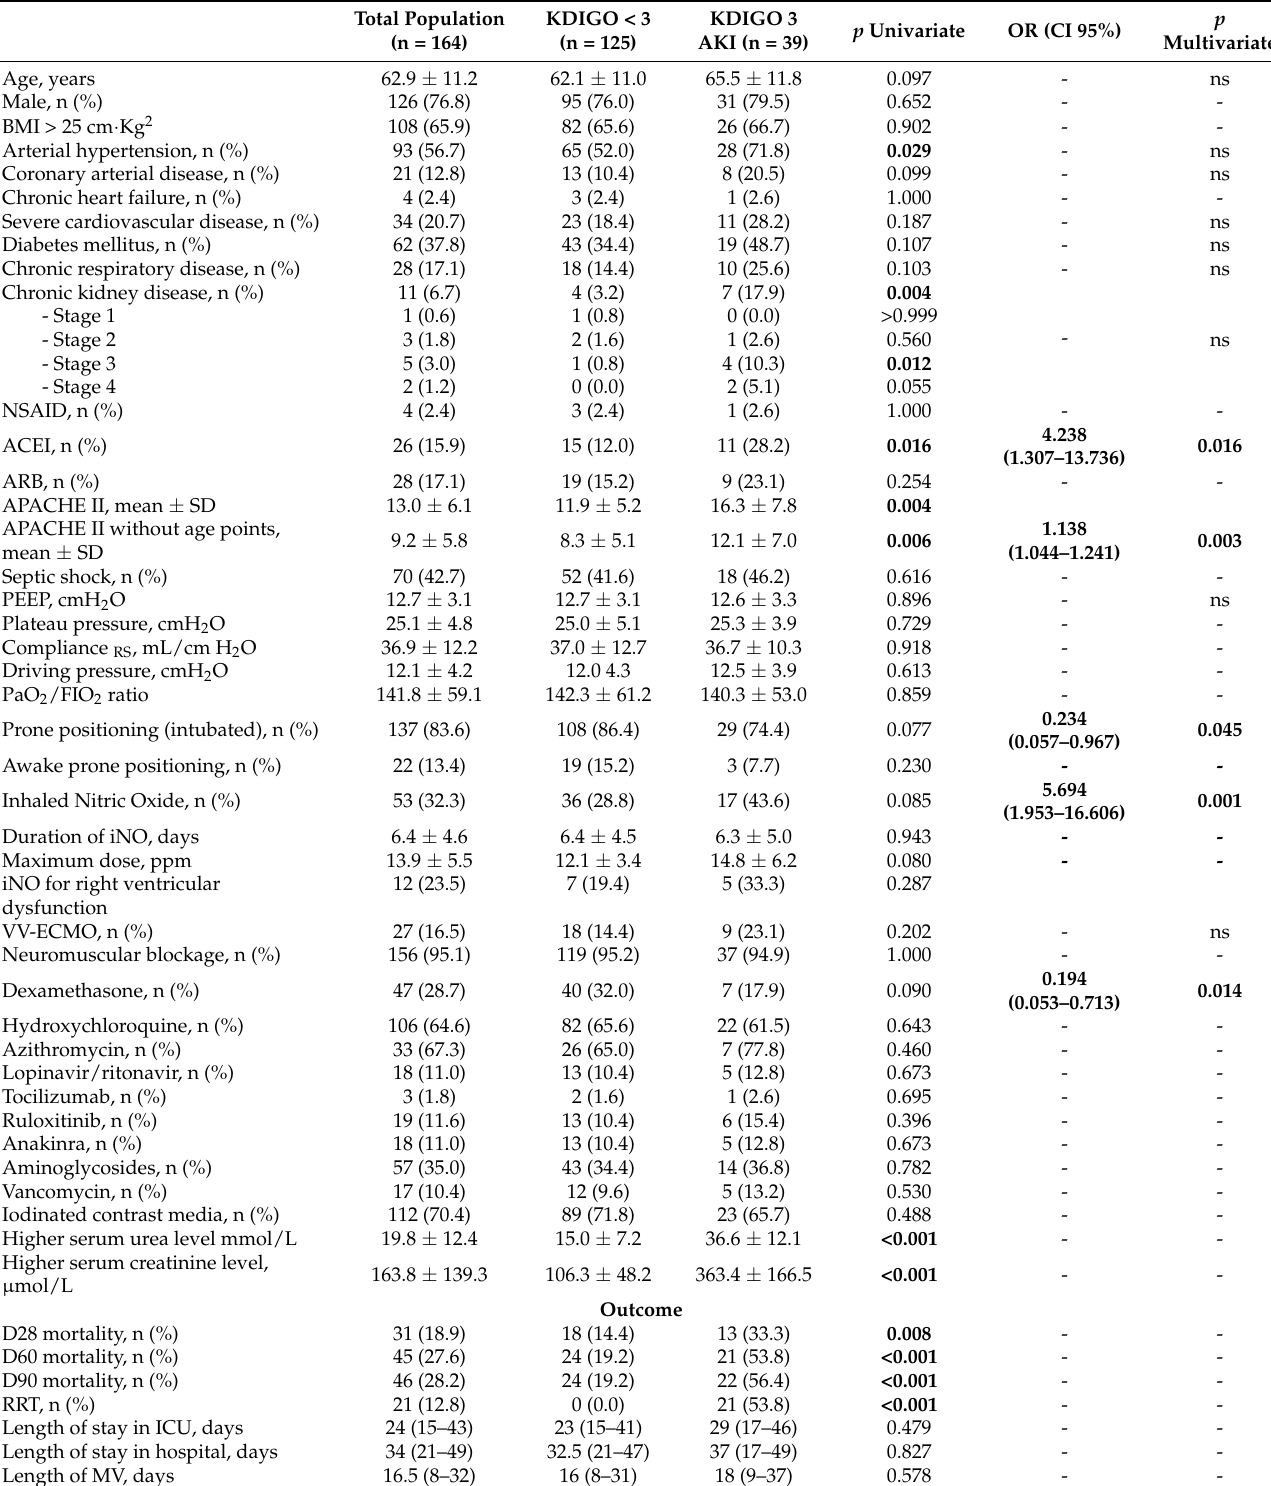
Table 1. Risk factors of stage III AKI in univariate and multivariate analysis. ACEI: Angiotensin- converting enzyme inhibitors, AKI: Acute Kidney Injury, ARB: Angiotensin receptor blocker, BMI: Body mass index, OR: Odds Ratio, ICU: Intensive Care Unit, MV: Mechanical ventilation, NSAID: Non-steroidal anti-inflammatory drugs, RRT: Renal replacement therapy, VV-ECMO: Veno-venous extra-corporeal membrane oxygenation. Bold: significant ( p <